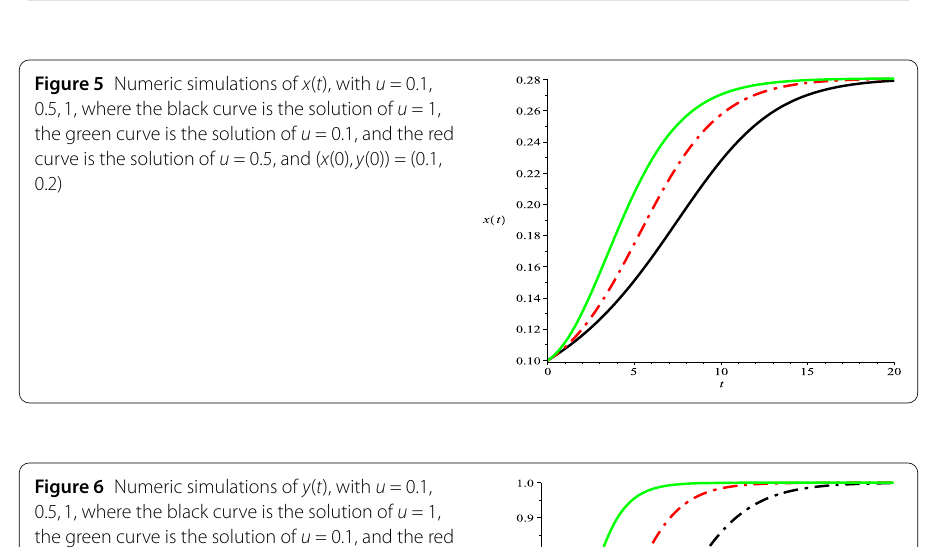
Figure 6 Numeric simulations of y ( t ), with u = 0.1, 0.5,1, where the black curve is the solution of u = 1, the green curve is the solution of u = 0.1, and the red curve is the solution of u = 0.5, and ( x (0), y (0)) = (0.1,